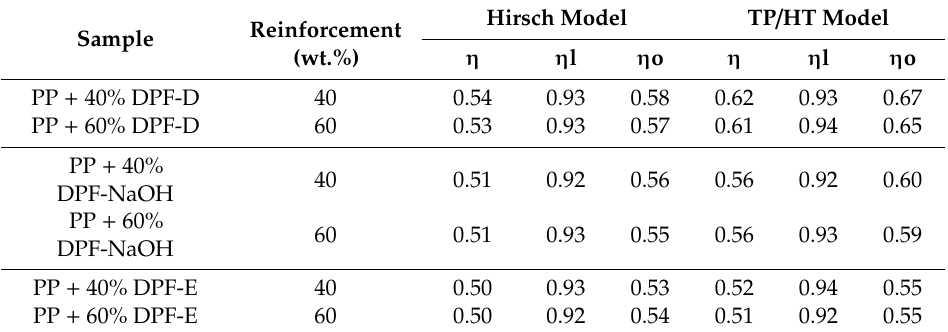
Table 4. Modulus e ffi ciency factor ( η ), modulus length factor ( η l) and modulus orientation factor ( η